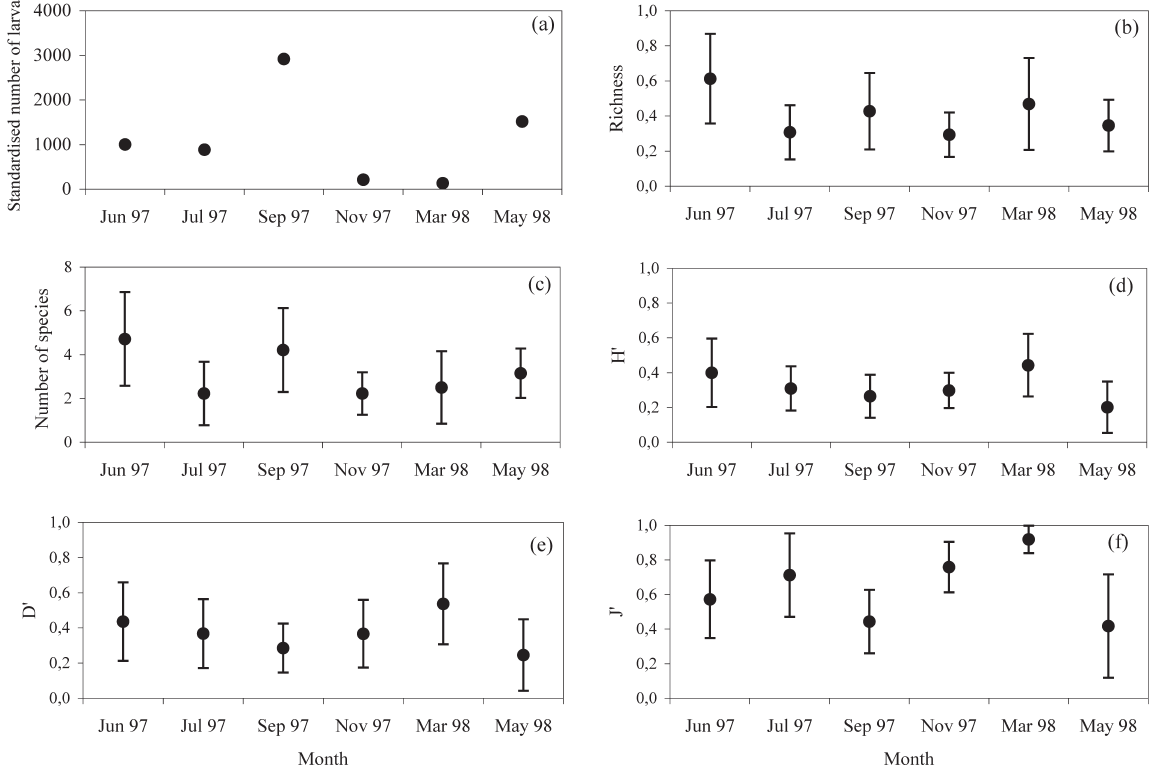
indicate ± standard